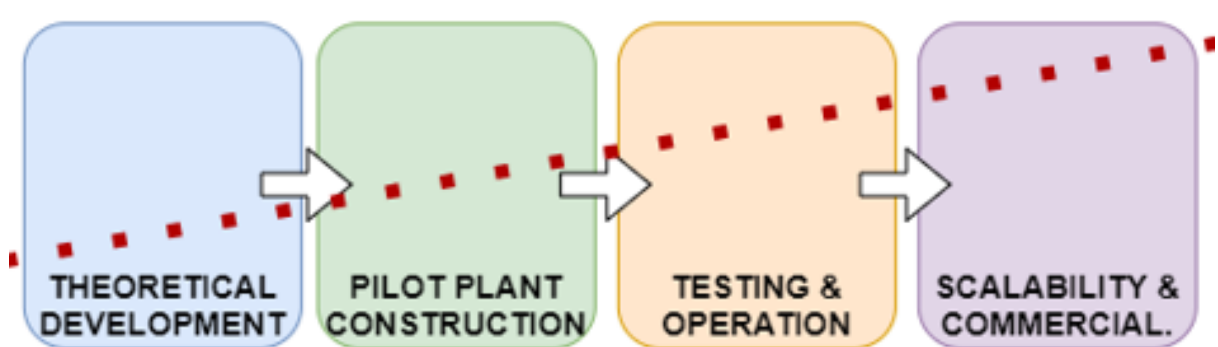
Figure 3. Project lifecycle stages .